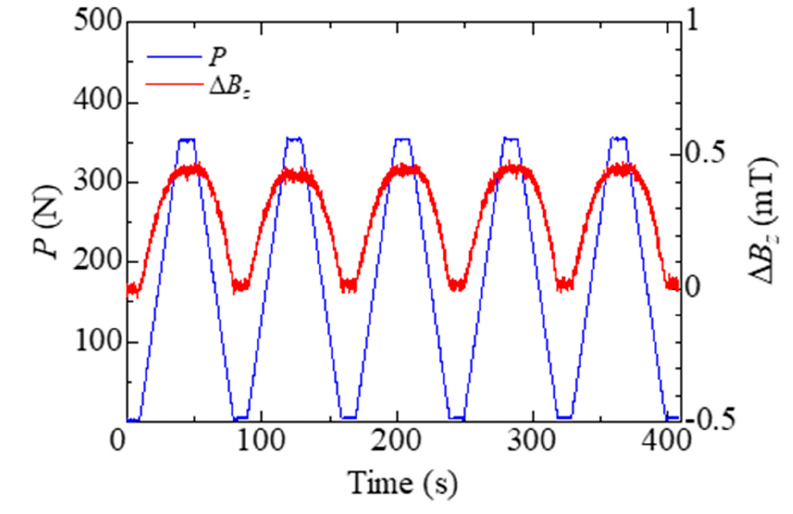
Figure 4. Load P and magnetic flux density change Δ B z versus time.